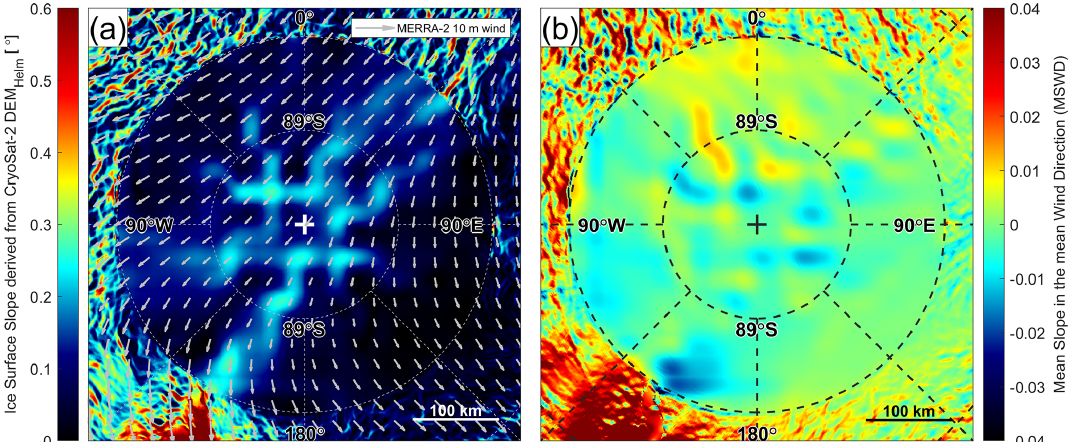
Figure A1. (a) Ice surface slope in degrees derived from CryoSat-2 (Helm et al., 2014a) and 26-year 10m wind average from MERRA-2 (e.g., Gelaro et al., 2017). (b) Mean slope in the mean wind direction (MSWD).